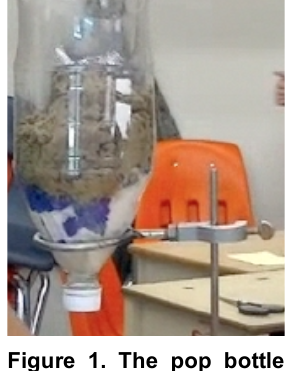
Figure 1. The pop bottle water